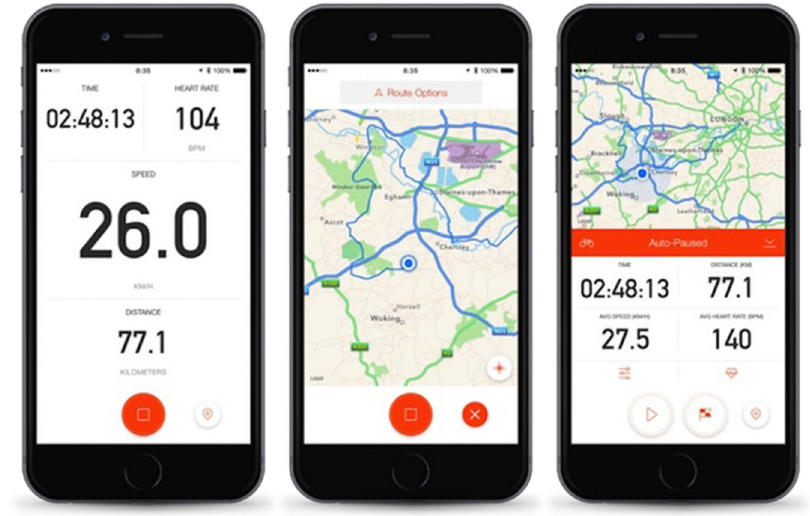
Fig. 2 Real-time data visualisations. Visualisations of an individual user ’ s cycling data as shown to the user in the app Strava.